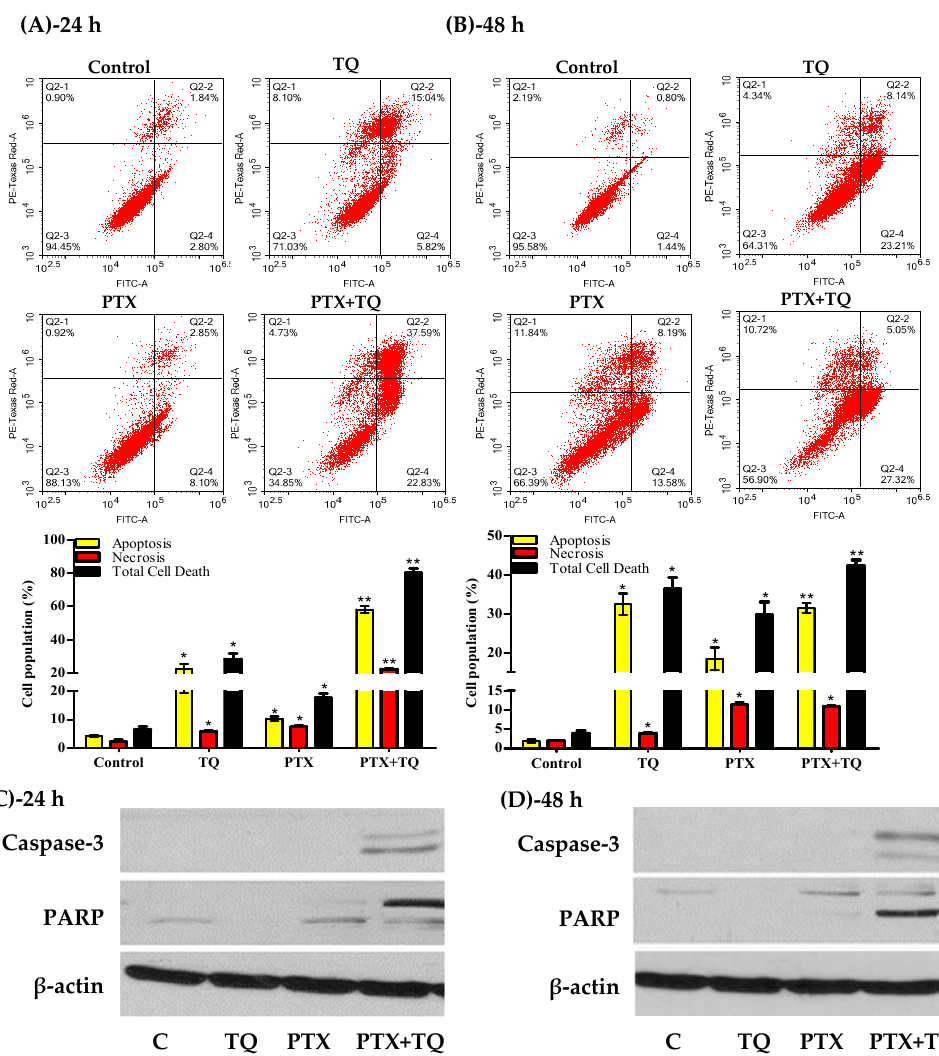
Figure 4. Apoptosis / necrosis assessment in T47D cells after exposure to PTX, TQ, and their combination. Cells were exposed to PTX, TQ, or their combination for 24 h ( A ) and 48 h ( B ). Cells were stained with annexin V-FITC / PI and different cell populations are plotted as a percentage of total events. Western blot analysis for caspase-3 and PARP was assessed for MCF-7 ( C ) and T47D ( D ) cells. Data are presented as mean ± SD; n = 3. (*) significantly different from the control group. (**) significantly different from PTX treatment.